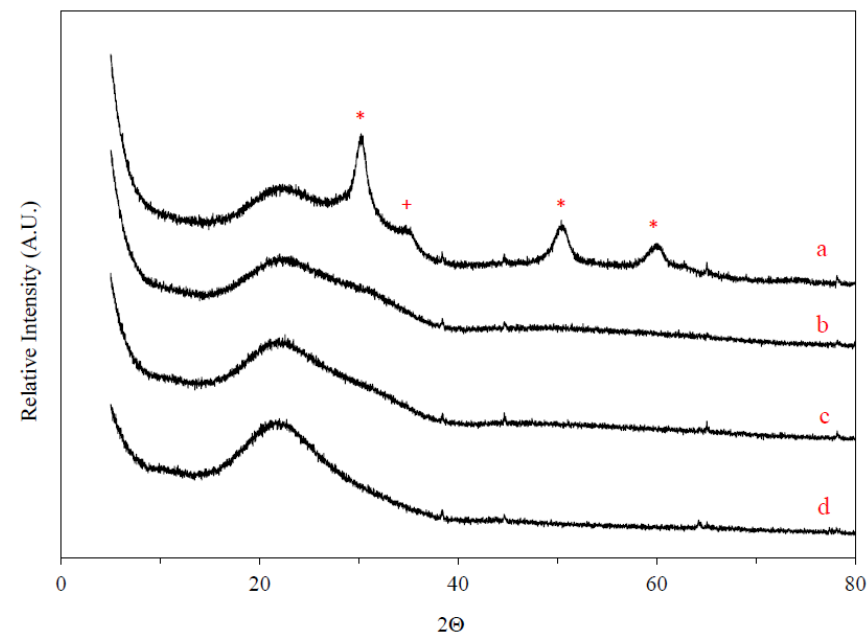
Figure 1. X-ray diffraction (XRD) patterns: ( a ) 25ZrOx/S, ( b ) 20ZrOx/S, ( c ) 10ZrOx/S, and ( d ) 5ZrOx/S. (*) ZrO 2 , (+) ZrSiO 4 .